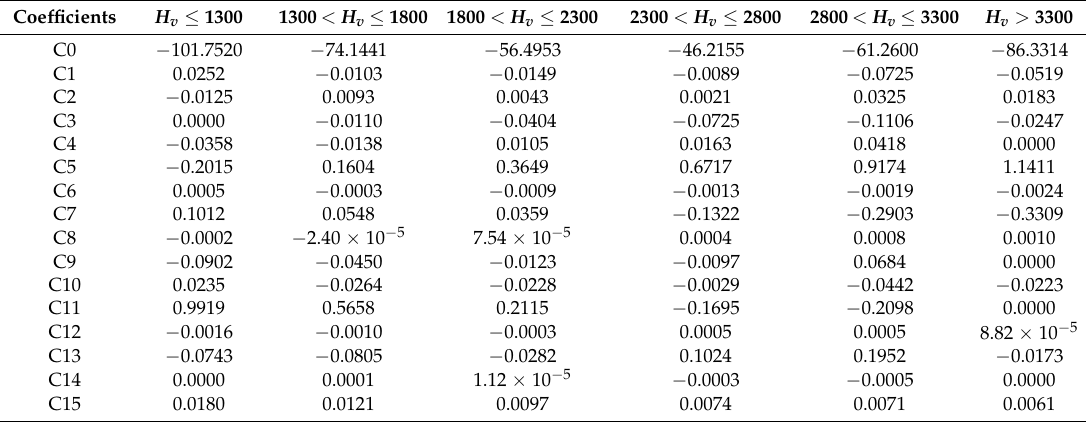
Table A3. Regression coefficients of proposed model for different water vapor scale heights H v